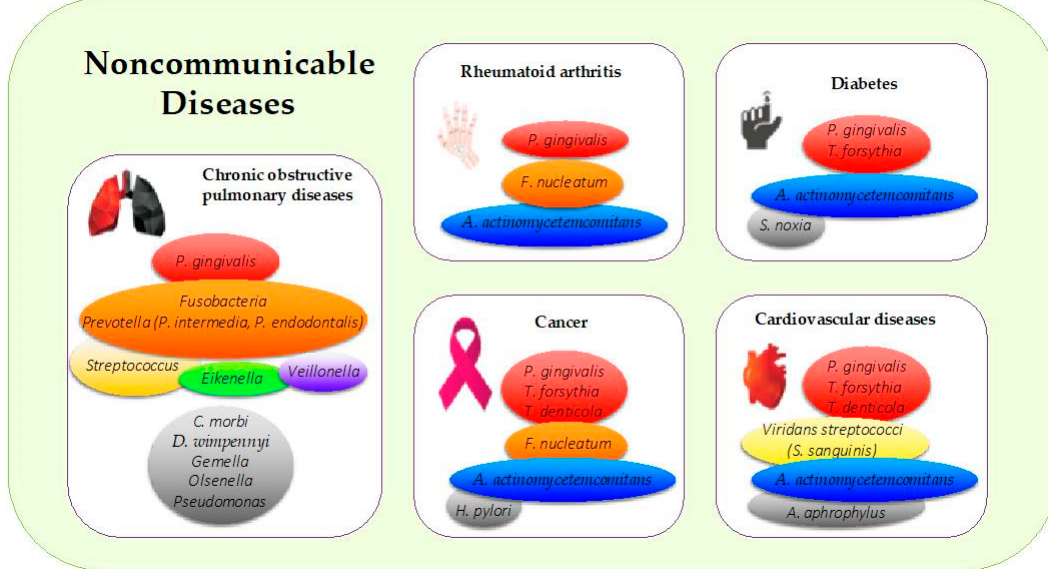
Figure 2. Periodontal pathogens implicated in the most common noncommunicable diseases. The colors in boxes refer to (i) the colors of the Socransky complexes for the purple, green, yellow, orange, and red colors, and (ii) other periodontal bacteria for the gray color. A. actinomycetemcomitans: Aggregatibacter actinomycetemcomitans ; C. morbi : Cantonella morbi; D. wimpennyi: Dysgonomonas wimpennyi; F. nucleatum: Fusobacterium nucleatum; H. pylori: Helicobacter pylori; P. gingivalis : Porphyromonas gingivalis ; S. noxia : Selenomonas noxia; S. sanguinis : Streptococcus sanguinis ; T. denticola : Treponema denticola ; T. forsythia : Tannerella forsythia.